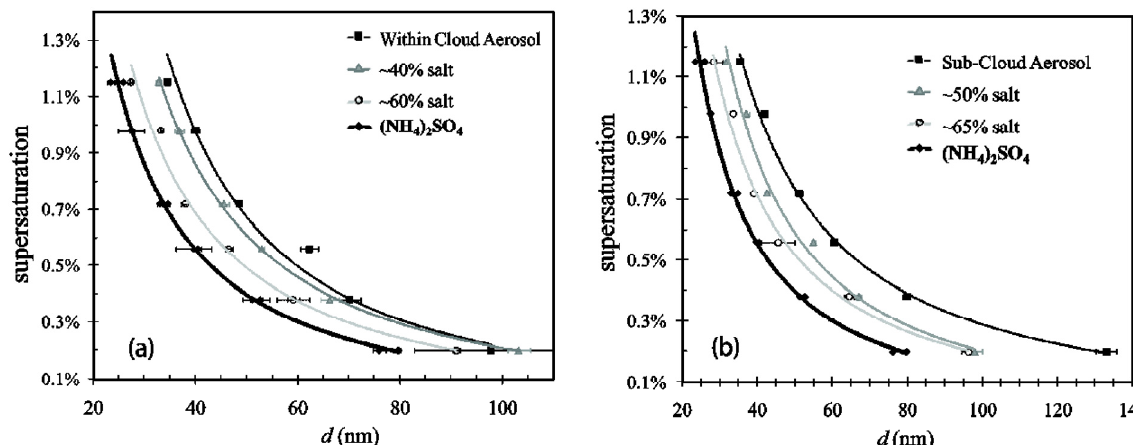
Figure 5. CCN activity of MASE samples with the addition of (NH 4 ) 2 SO 4 . Salt contents are expressed in terms of mass fraction. ( a ) Cloud Residuals and ( b ) Sub-Cloud